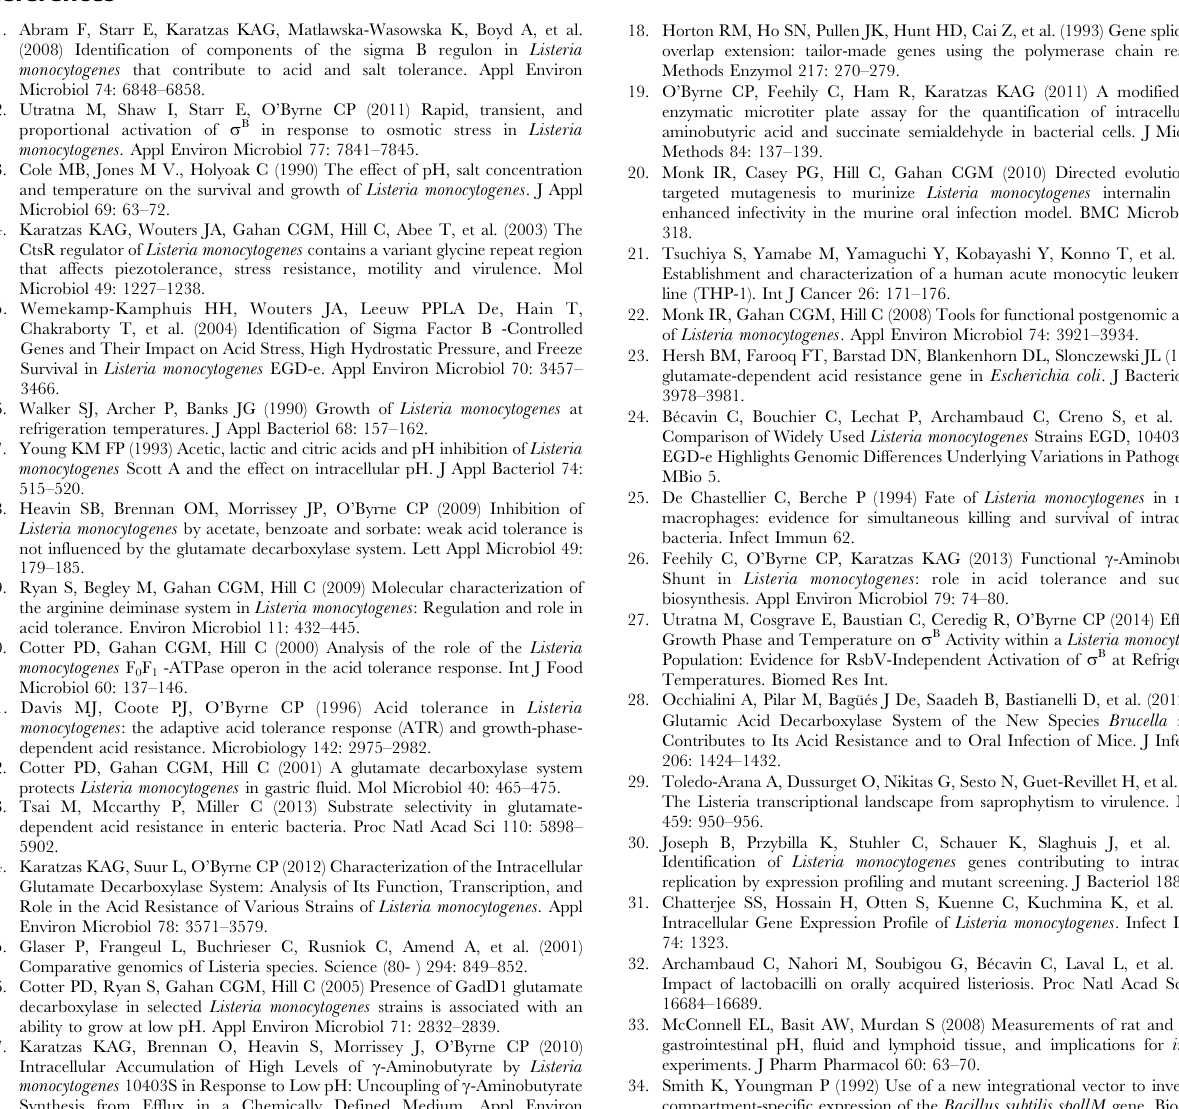
experiment. Error bars represent the standard deviation from the mean of three individual biological repeats for each